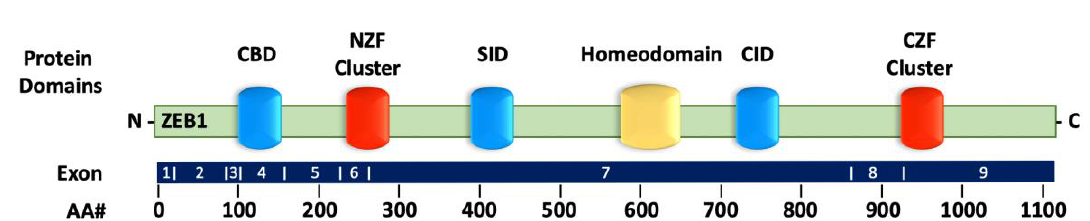
Figure 1. The ZEB1 structure. The homologous structural homeodomain (at aa 581–640) is in between the amino- and carboxy-terminal zinc finger domains (aa 240 to 277 and aa 918 to 971). The CBD, SID, and CID are shown. NZF: amino-terminal zinc finger cluster, CZF: carboxy-terminal zinc finger cluster, SID: Smad interaction domain, CID: CtBP interaction domain, and CBD: P300-P/CAF interaction domain.